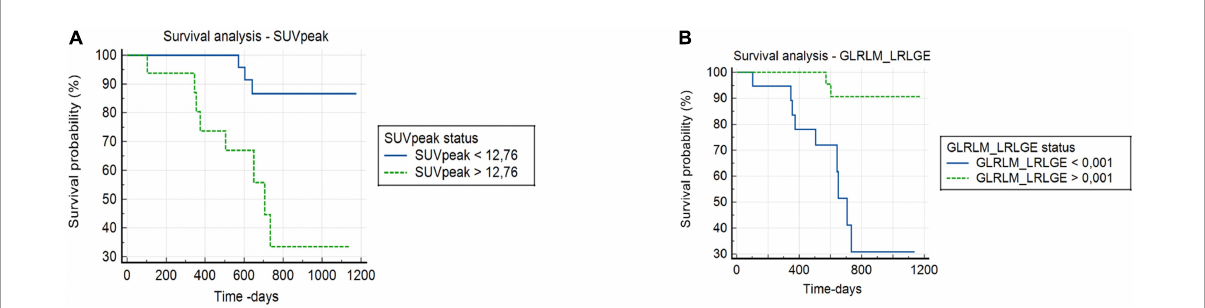
FIGURE2 Kaplan–Meier survival curve of overall survival in patients with cervical cancer. (A) High SUVpeak value ( > 12.76) and low SUVpeak value ( < 12.76). (B) High GLRLM_LRLGE value ( > 1.10 - 3 ) and low GLRLM_LRLGE value ( < 1.10 - 3 ).